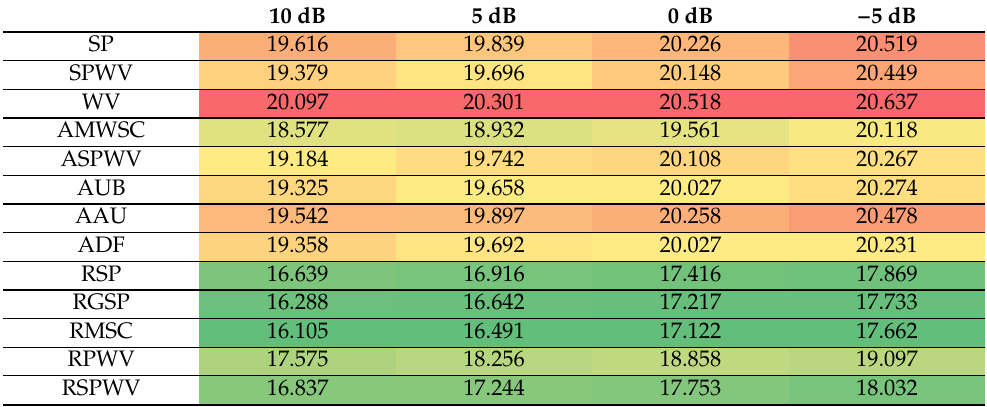
Table 6. TFR Rényi entropy for a noisy multi-component signal with successive parabolic and linear FM components for different SNR levels (averaged over 100 noise realizations), cell colors range from green for the best result to red for the worst result in each column